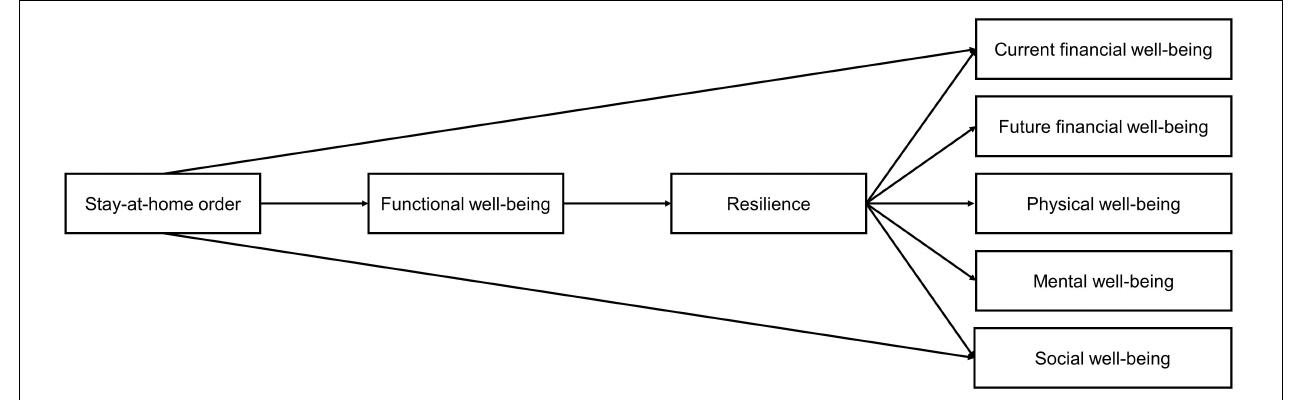
FIGURE 1 | Conceptual model depicting hypothesized relationships between stay-at-home orders, resilience and components of well-being.